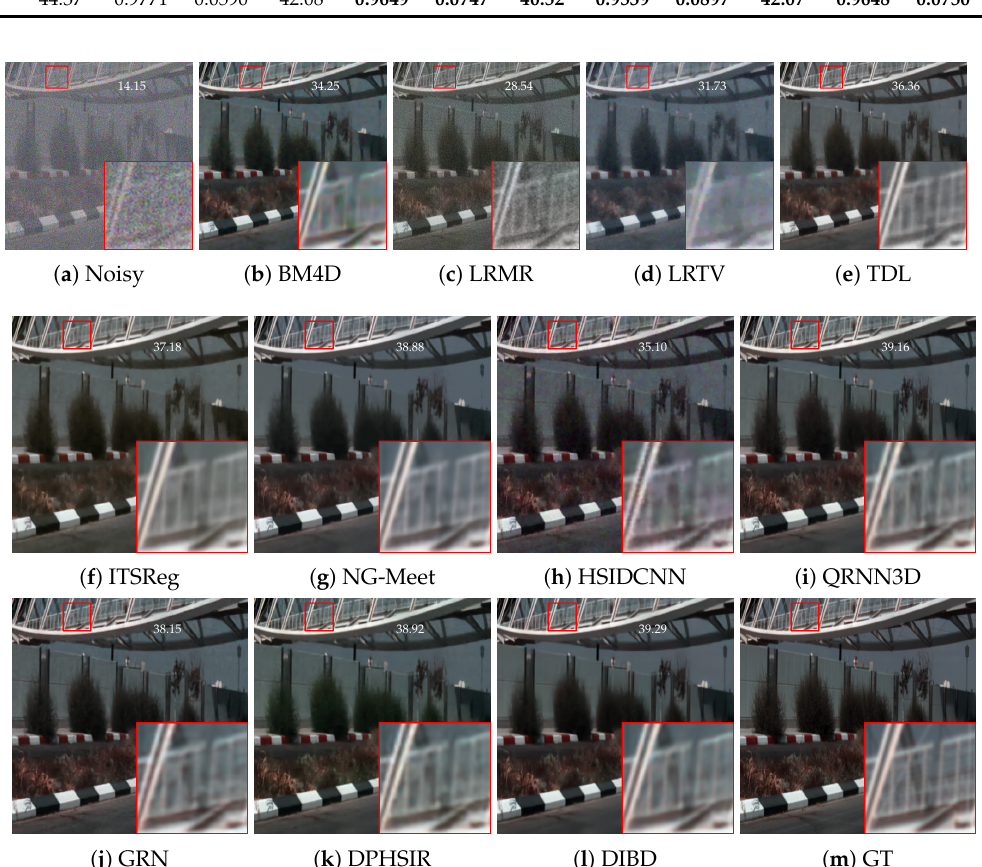
Figure 3. Denoising results (PSNR, dB) and visual comparison of the image from the ICVL dataset under the AWGN intensity σ = 50. The RGB image is synthesized by HSI bands 23, 12,